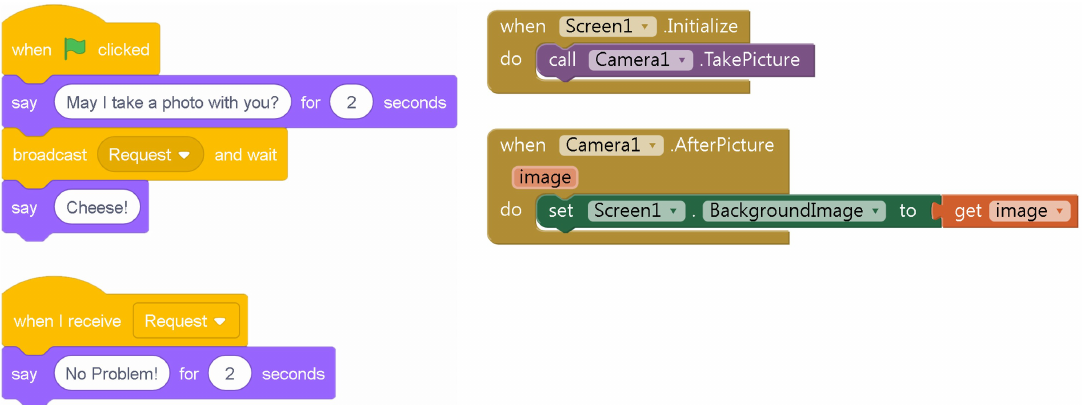
Figure 2. Example codes that have nearly identical structures in different languages related to Synchronization. Comparison of the “Broadcast and wait” statement used in Scratch (on the left side